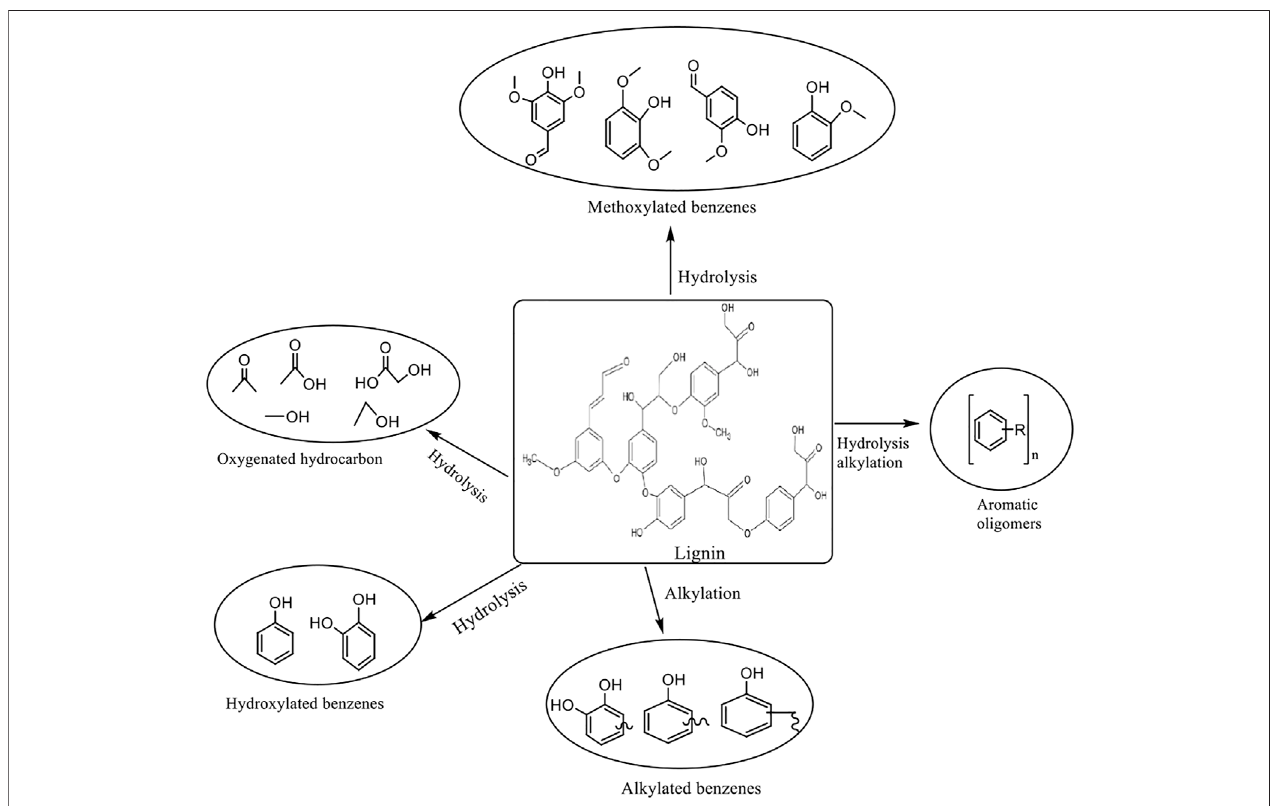
FIGURE 4 | Proposed subunits of lignin through a steam explosion